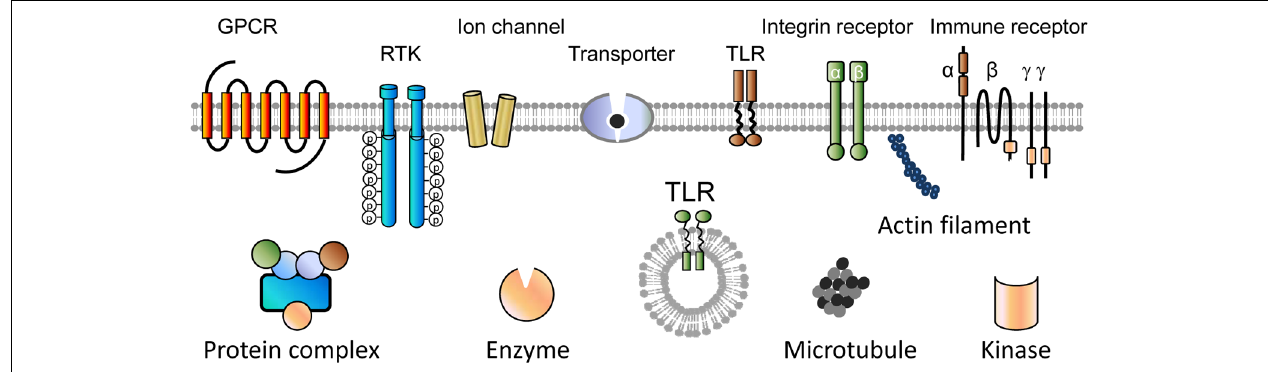
FIGURE 3 |Target receptor classes whose activation or modulation has been shown to trigger characteristic biosensor responses in living cells. Label-free receptor signaling profiling has wide coverage in targets and pathways. GPCR, G protein-coupled receptor; RTK, receptor tyrosine kinase;TLR, Toll-like